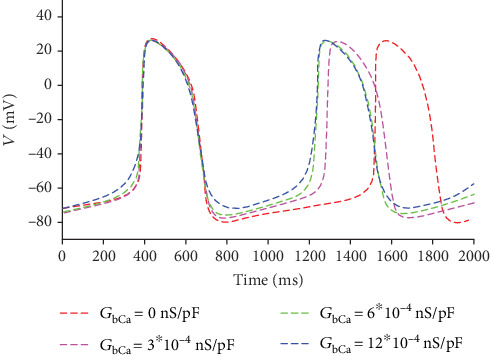
APs corresponding to different GbCa.